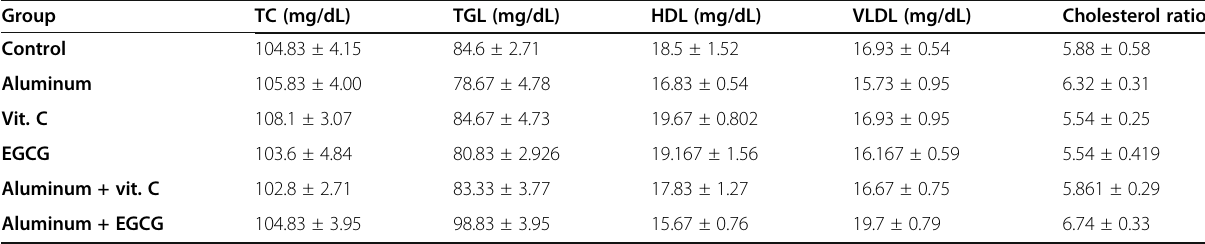
Table 2 Effect of EGCG on the lipid profile of the rats